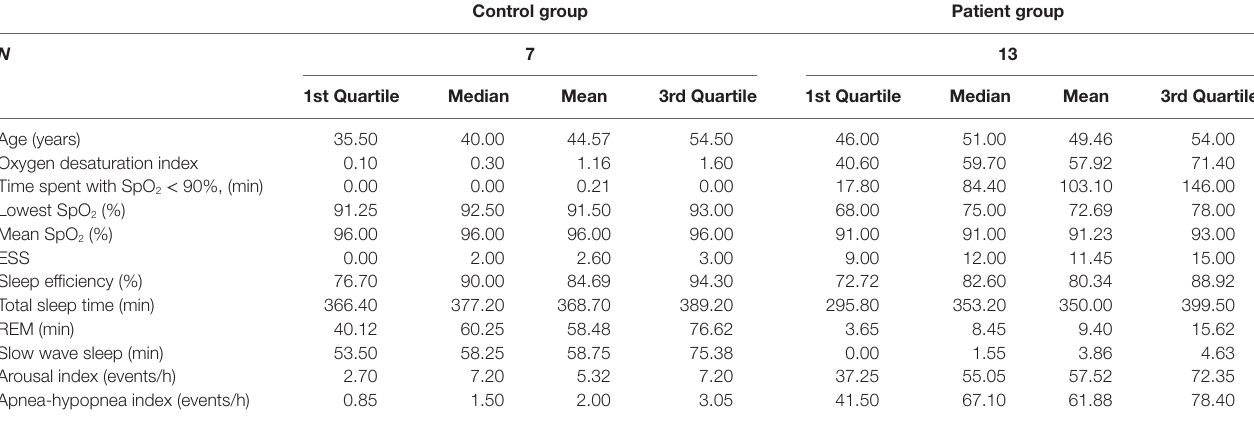
TaBle 1 | Polysomnography characterization of healthy controls and obstructive sleep apnea syndrome patients, before continuous positive airway pressure treatment. control group Patient